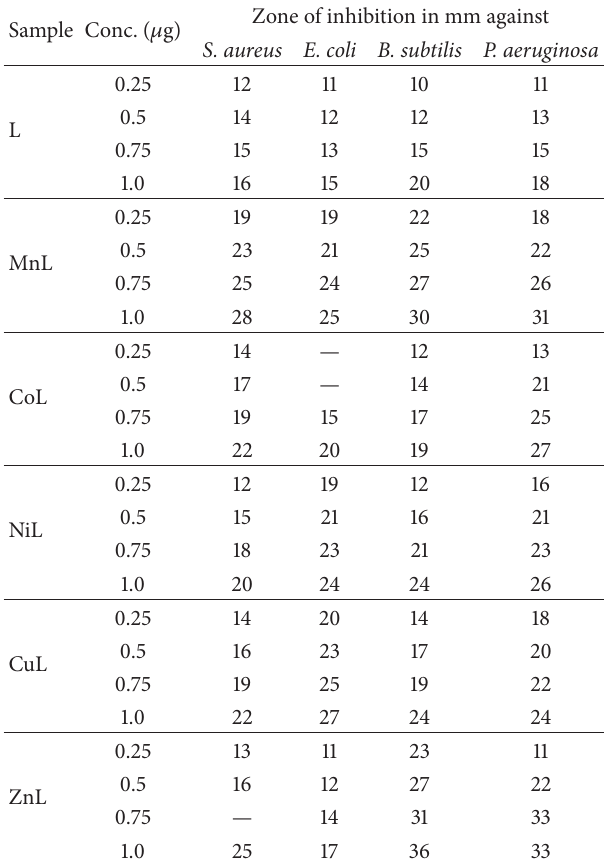
Table 3: Minimum inhibitory zones for ligand and